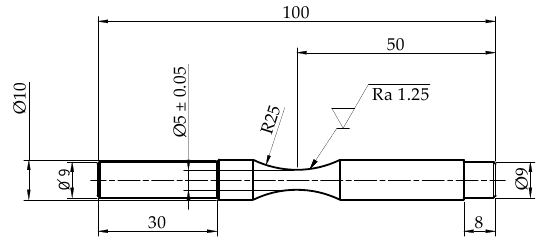
Figure 4. Geometry of the round specimen for fatigue testing.